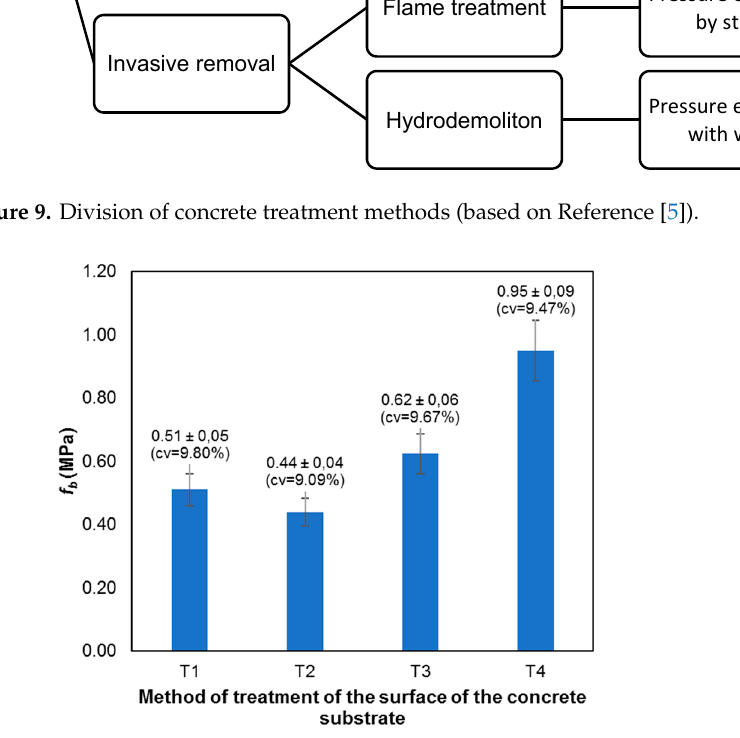
Figure 10. The test results of the pull-off adhesion f b between the overlay and the existing concrete substrate using the pull-off method (based on the results presented in Reference [44]). Methods of surface treatment: T1—patch grabbed (raw) surface, T2—formed after contact with formwork (as cast) surface, T3—mechanically grinded surface, T4—shot-blasted surface.